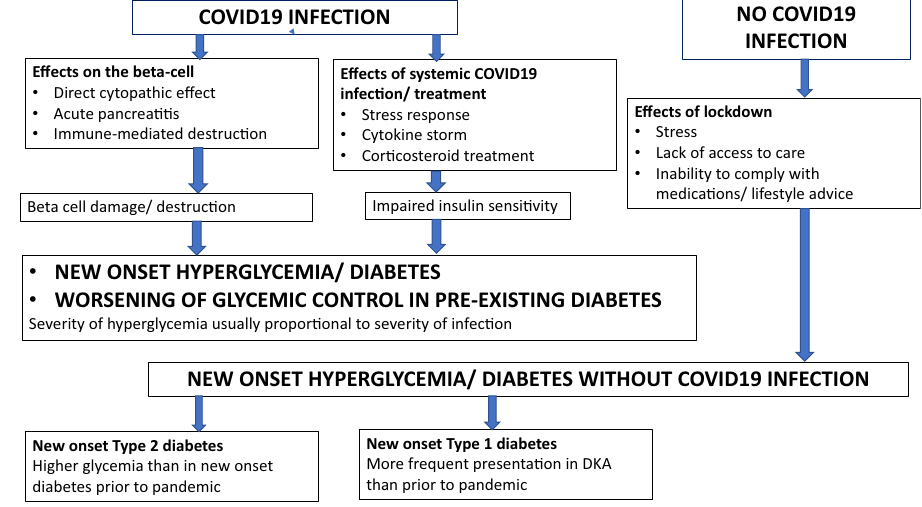
Fig. 1 Hyperglycemic states during COVID